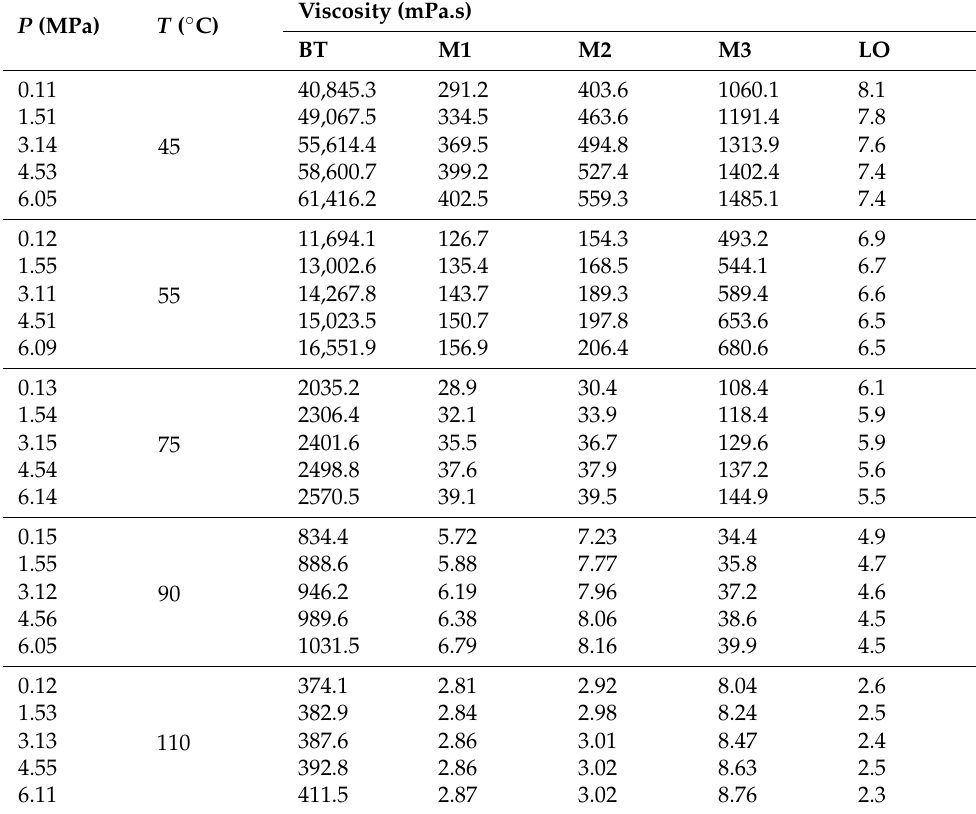
Table 2. Experimental viscosity